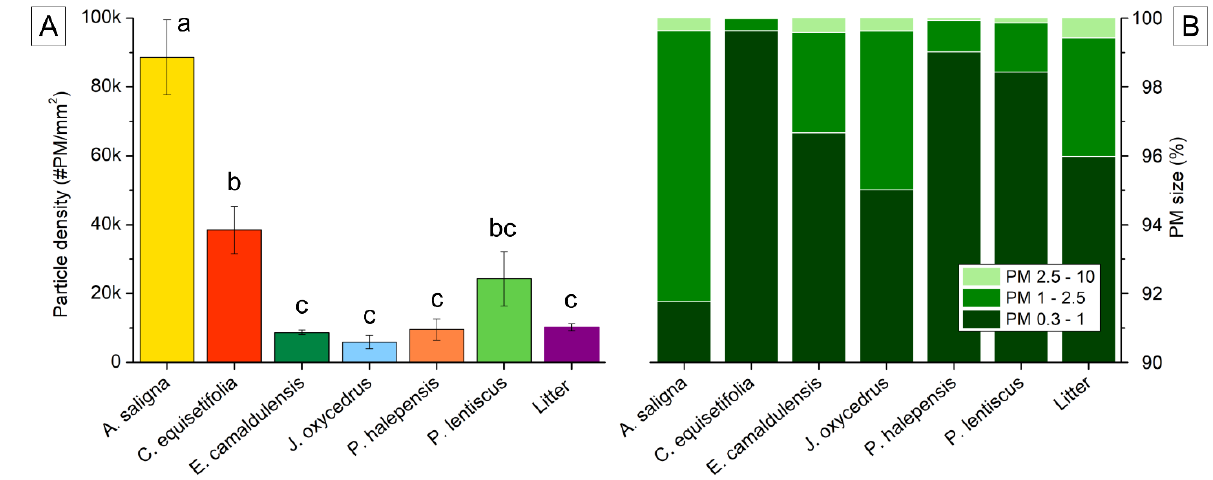
Figure 2. ( A ) The total particle density presented as number of particles on mm 2 ± standard error for litter and species sampled in the study area; homogeneous groups were calculated through Tukey HSD-test, and are represented by the letters (a–c) above each column. ( B ) Particle size fractions (PM 2.5–10, PM 1–2.5 and PM 0.3–1) expressed as a percentage for the litter and species sampled in the study area.